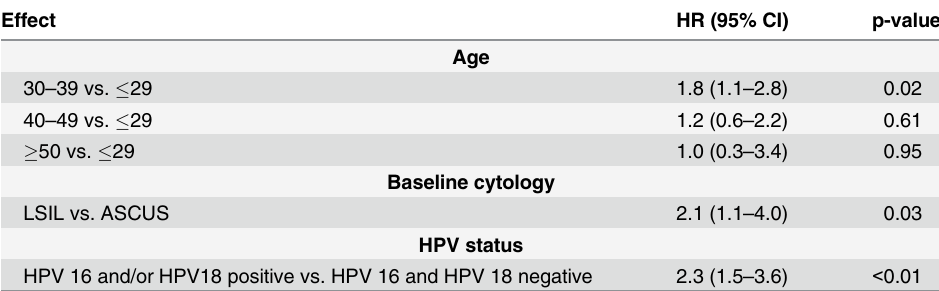
Table 3. Adjusted multivariable model * — full study population.